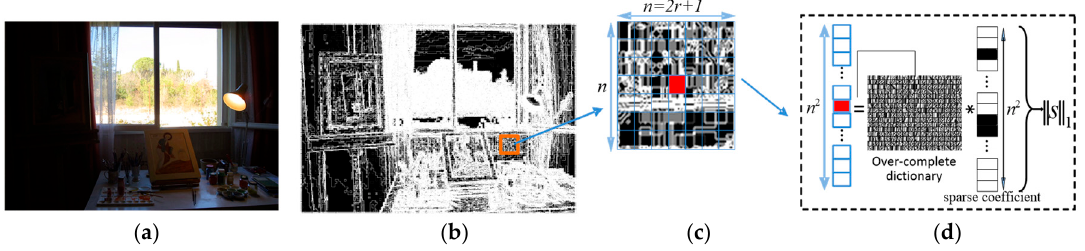
Figure 5. Local gradient sparse descriptor acquisition: ( a ) Input image; ( b ) Input luminance gradient map; ( c ) Luminance gradient patch; ( d ) Local gradient sparse descriptor ‖ S ‖ 1 .